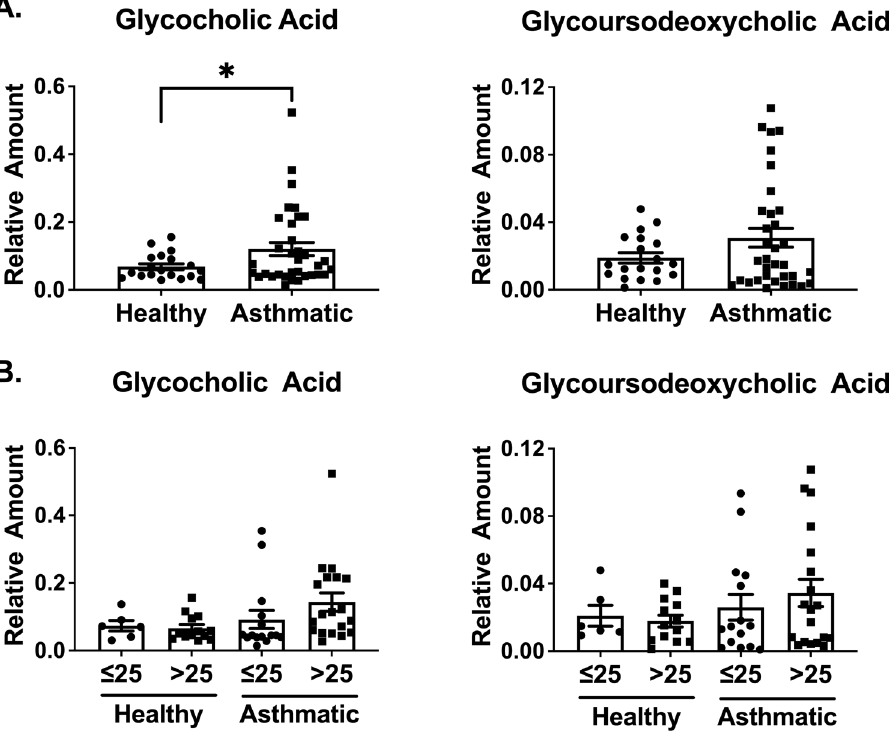
Figure 1. Human plasma bile acid profiles are altered with obesity and asthma. Glycocholic acid (GCA) and glycoursodeoxycholic acid (GUDCA) levels were measured by stable isotope dilution-liquid chromatography- high resolution mass spectrometry (SID-LC-HRMS) in the plasma of individuals with asthma (n = 34) and controls (n = 19) (A) . GCA and GUDCA levels are also shown for healthy and asthmatic patients grouped by BMI: individuals with asthma with a BMI > 25 (n = 19), lean healthy controls with a BMI > 25 (n = 6), healthy individuals with a BMI > 25 (n = 13), and lean individuals with asthma (n = 15) (B) . *p <